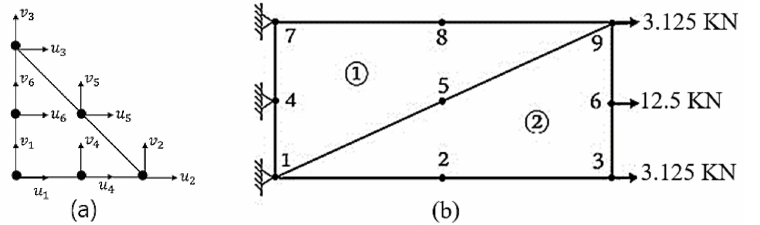
Figure 2. Example: ( a ) 6-noded triangular element (LST), and ( b ) node and element numbering together with the boundary and loading conditions [45].